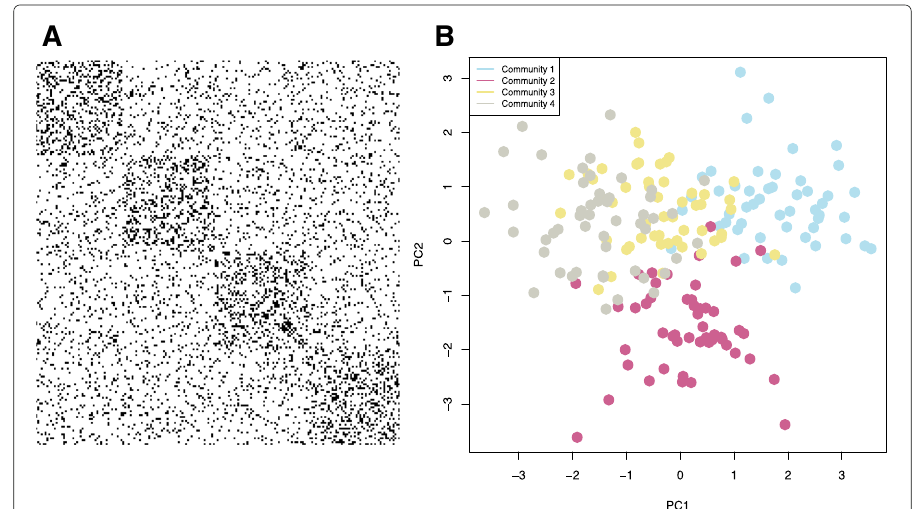
Fig. 2 Synthetic Example. We generated a synthetic network with N = 200 nodes, K = 4 communities and an 8-dimensional multivariate Gaussian for each community. a . A visualization of the adjacency matrix for this network where a black dot indicates an edge. We observe that there is an assortative block structure (blocks on the diagonal), but there are also many edges between communities making the true community structure using only connectivity harder to detect. b . We performed PCA on the N × p attribute array and plotted each of the N nodes in two dimensions. Points are colored by their true community assignments, z . Clustering the nodes according to only connectivity, only attributes, and with the attributed SBM, we quantified the partition accuracy with normalized mutual information, yielding NMI ( z , { z connectivity , z attributes , z attributesbm } ) = { 0.65,0.68,0.83